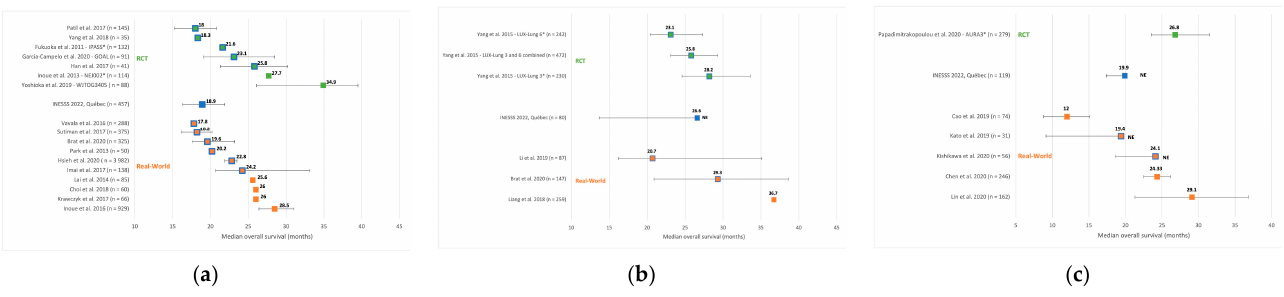
Figure 5. Comparison of overall survival estimates with RCTs and real ‐ world studies: ( a ) 1st ‐ line gefitinib; ( b ) 1st ‐ line afatinib; ( c ) Post ‐ EGFR ‐ TKI osimertinib cohort. * Studies submitted to INESSS for evaluation. Abbreviations: RCT: randomized controlled trial; NE: upper bound of 95% confidence interval is non ‐ evaluable. The mustache around each estimate represents the 95% confidence interval. The orange or green square with a blue outline represents a median that is considered similar to Quebec’s median.